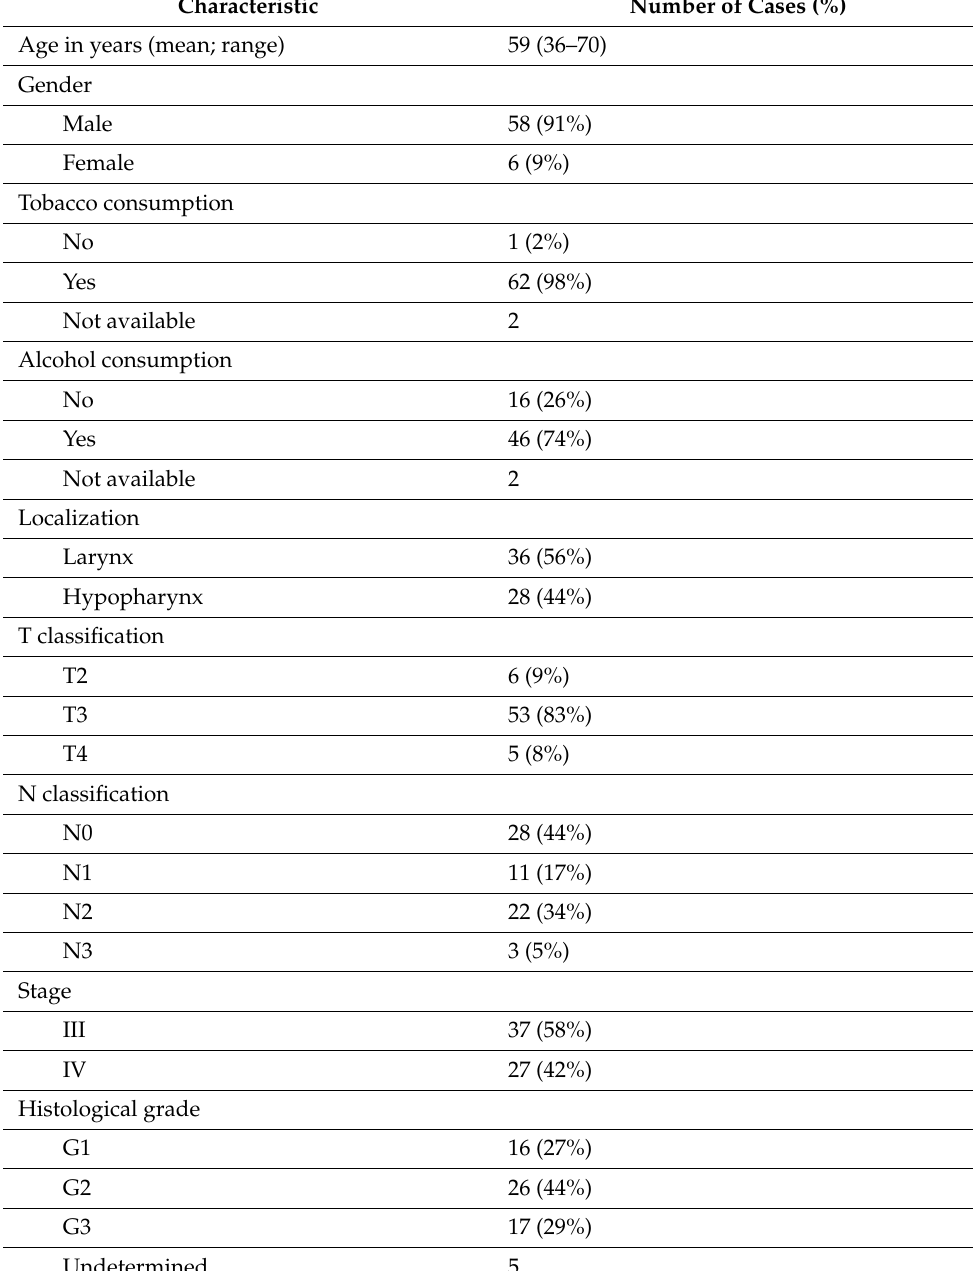
Table 1. Clinicopathological characteristics of the included